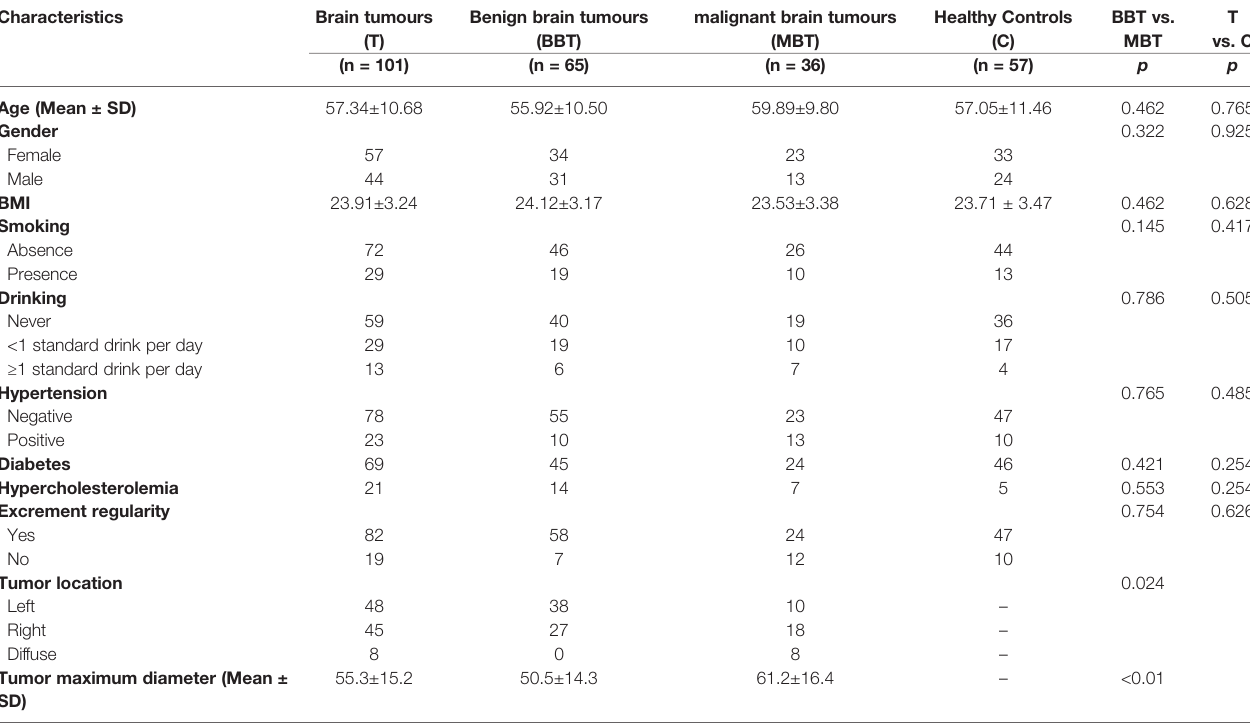
TABLE 1 | Descriptive data of included subjects in the study.